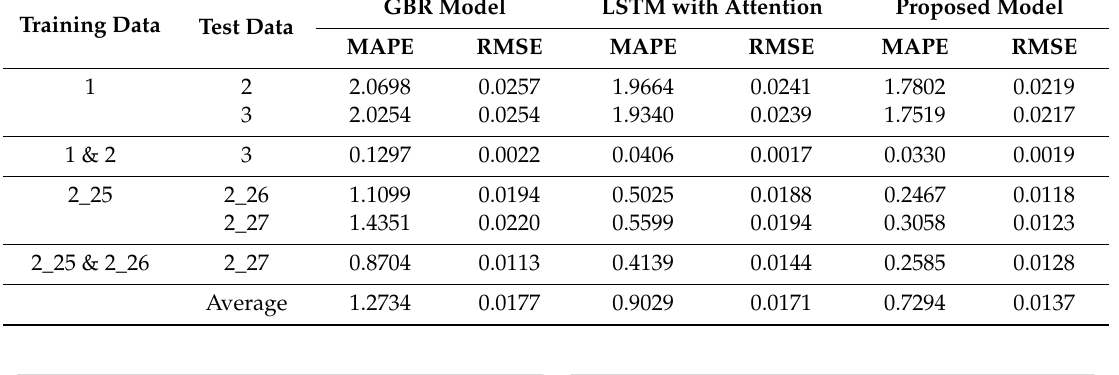
Table 5. The prediction performance of different models using one cell or two cells as training data.